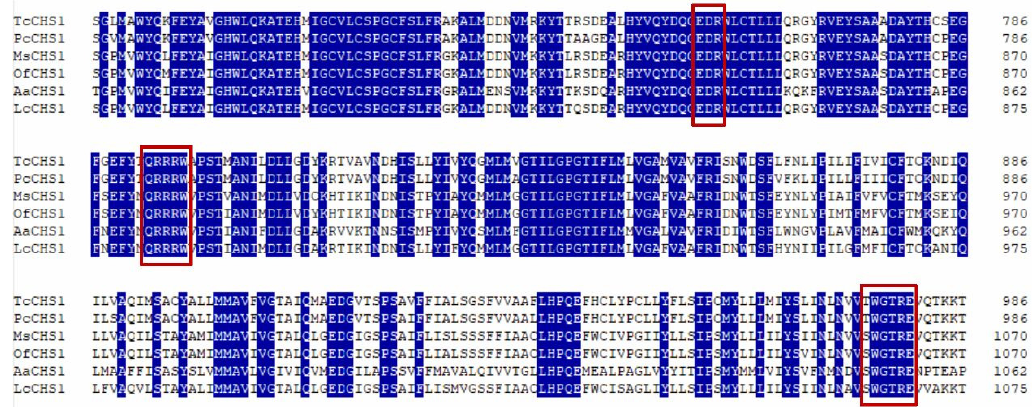
Figure 2. Alignment of putative-conserved catalytic domains of chitin synthase genes from two mite species and four insect species are suggested. The following insect and mite chitin synthase sequences were used in the alignment: Tetranychus cinnabarinus (Tc, KM242062), Panonychus citri (Pc, KM242063), Manduca sexta (Ms, AY062175), Ostrinia fur- nacalis (Of, EU376026), Aedes aegypti (Aa, AF223577), and Lucilia cuprina (Lc, AF221067). Numbers on the right side repre- sent amino acid positions. The chitin synthase signature sequences “EDR”, “QRRRW” and “TWGTR” in the domains of the deduced amino acid sequences are indicated in red boxes, respectively.